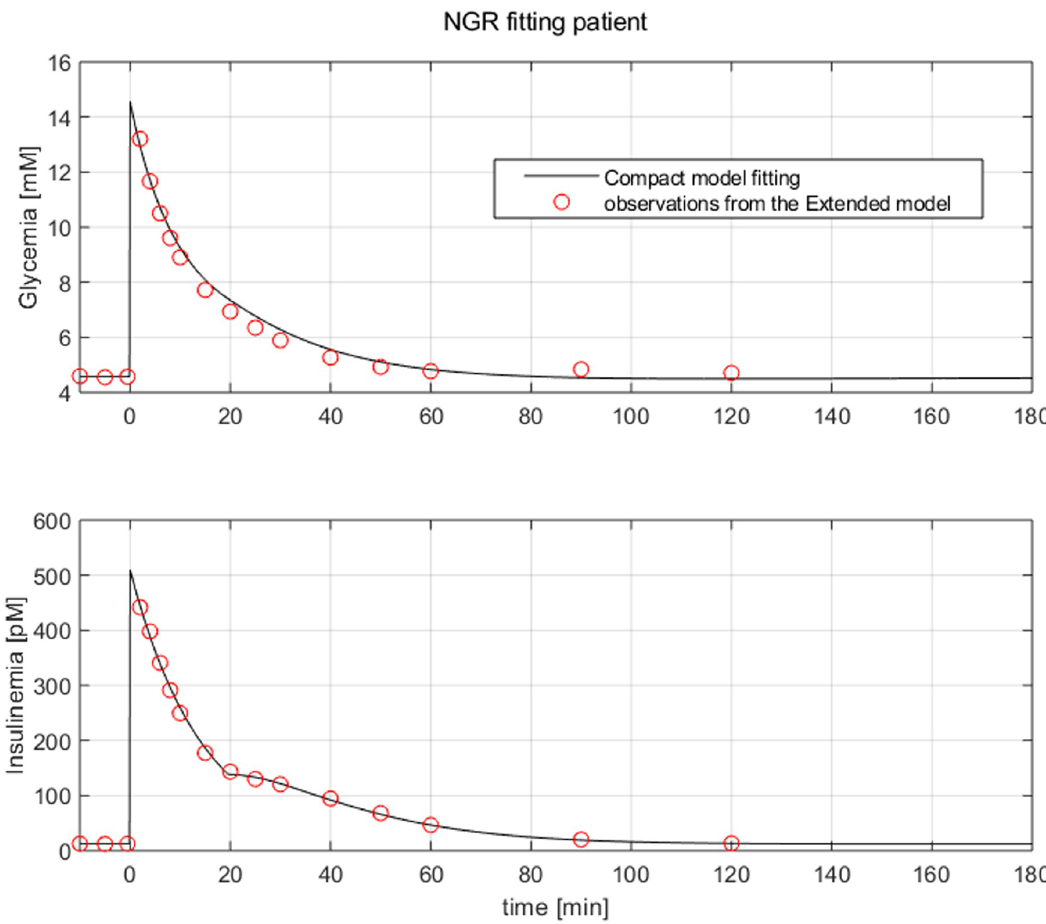
Fig 4. Observations extracted from a virtual NGR patient undergone an IVGTT (red dots). The black line represents the Compact Model fitting.